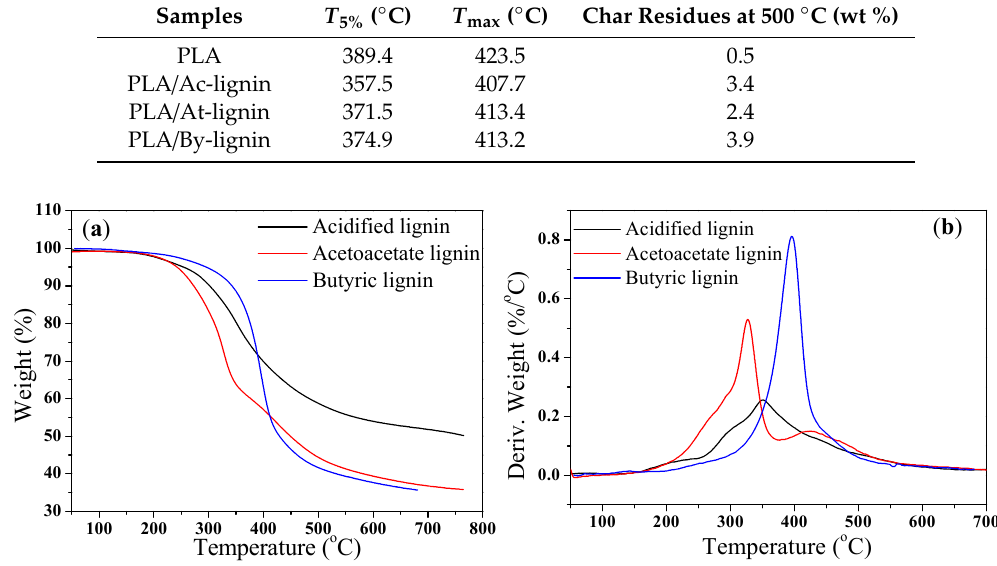
Figure 14. TGA ( a ) and derivative thermogravimetry (DTG) ( b ) curves of PLA and PLA/lignin biocomposites.